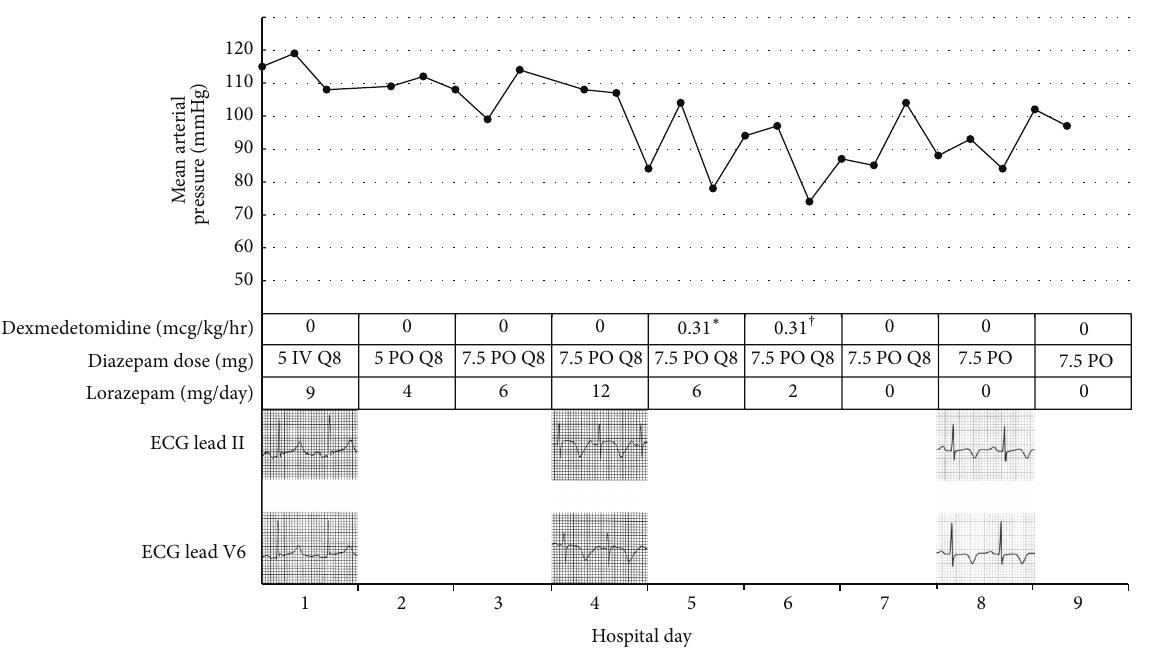
Figure 2: Mean arterial pressure versus time; graph of mean arterial pressure readings against time with corresponding scheduled doses of diazepam, administration of lorazepam, infusion of dexmedetomidine, and ECG changes. ∗ Infusion started at 11:15AM. Does not include initial loading dose of 1 𝜇 g/kg over 10 minutes. † Infusion stopped at 11:11AM.